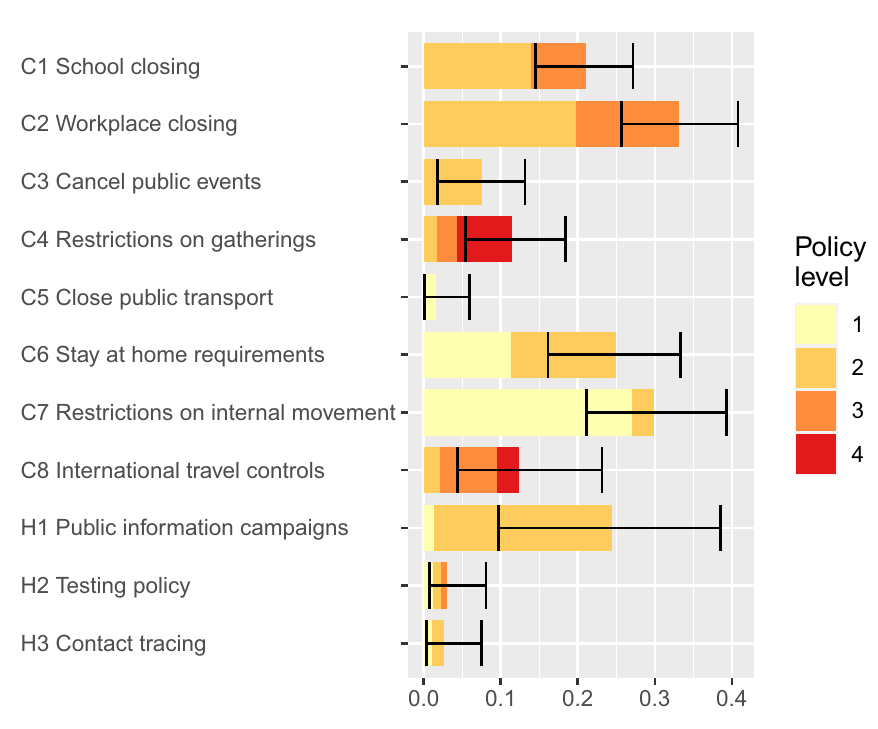
Fig 3. Marginal effect sizes of policy measures on reducing weekly growth rates. Bars = median estimate by policy level; Lines = 95% intervals for maximum policy